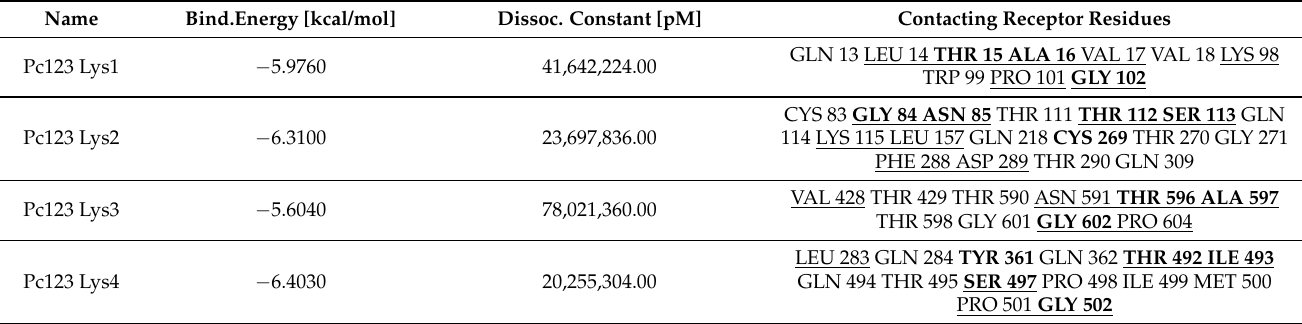
Table 2. Molecular docking. Amino acids that bind to the NAcGl substrate with the greatest probability for each of the putative LysM effectors of Pc123. Common amino acids that mediate substrate binding in Ecp6 and Pc123 are underlined and those common to the chitinase A from Pteris ryukyunensis and Pc123 are marked in bold.